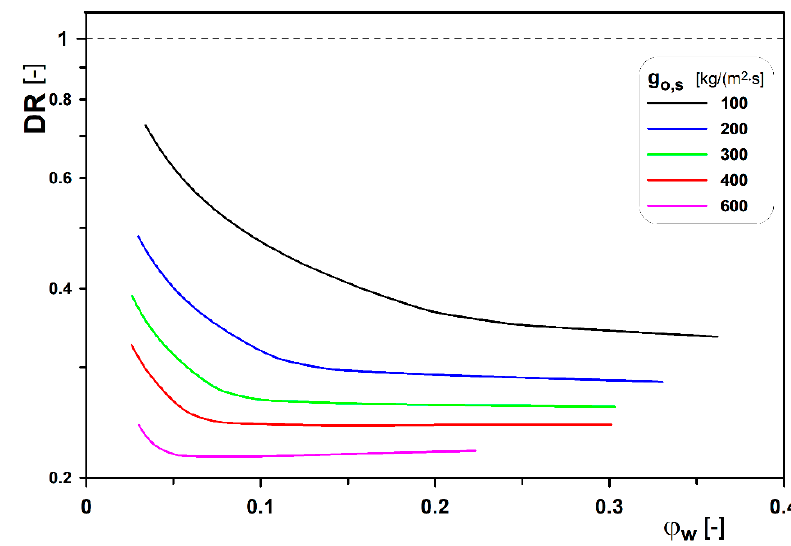
Figure 6. Variations in DR index for oil with a viscosity of η r =300.